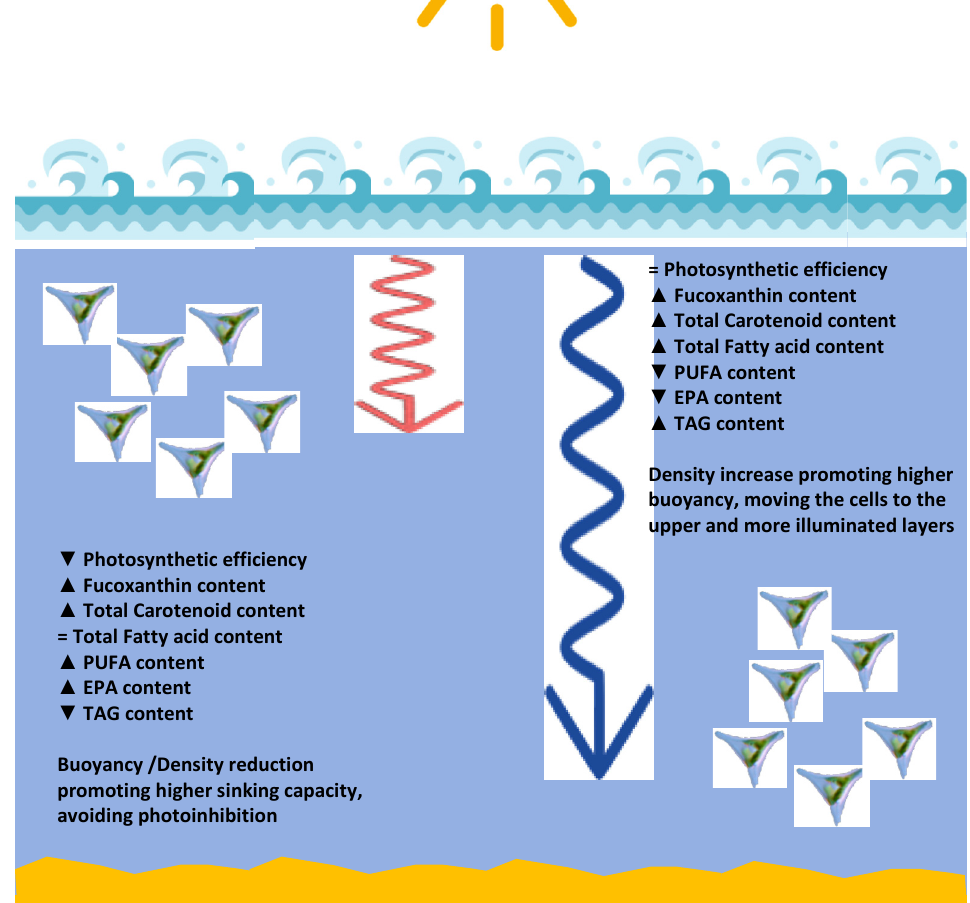
Figure 11. Schematic model of the metabolic changes induced by different wavelengths reaching the different depth layers of the ocean water column (blue and red arrows represent the penetration capacity of the red and blue wavelengths, respectively).